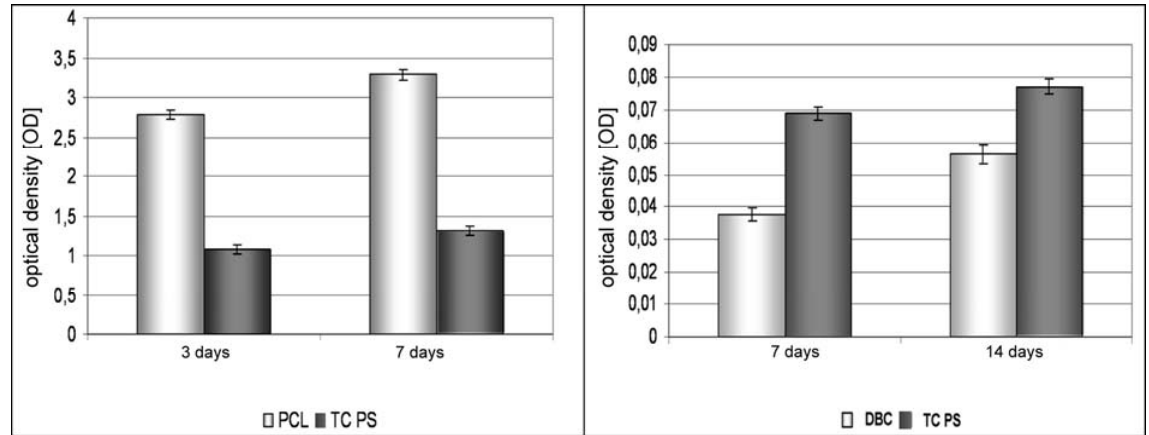
Figure 5. Data showing survival MTT activity cells contacted with the surface of PCL fabric (7-day culture) and DBC fabric (14-day